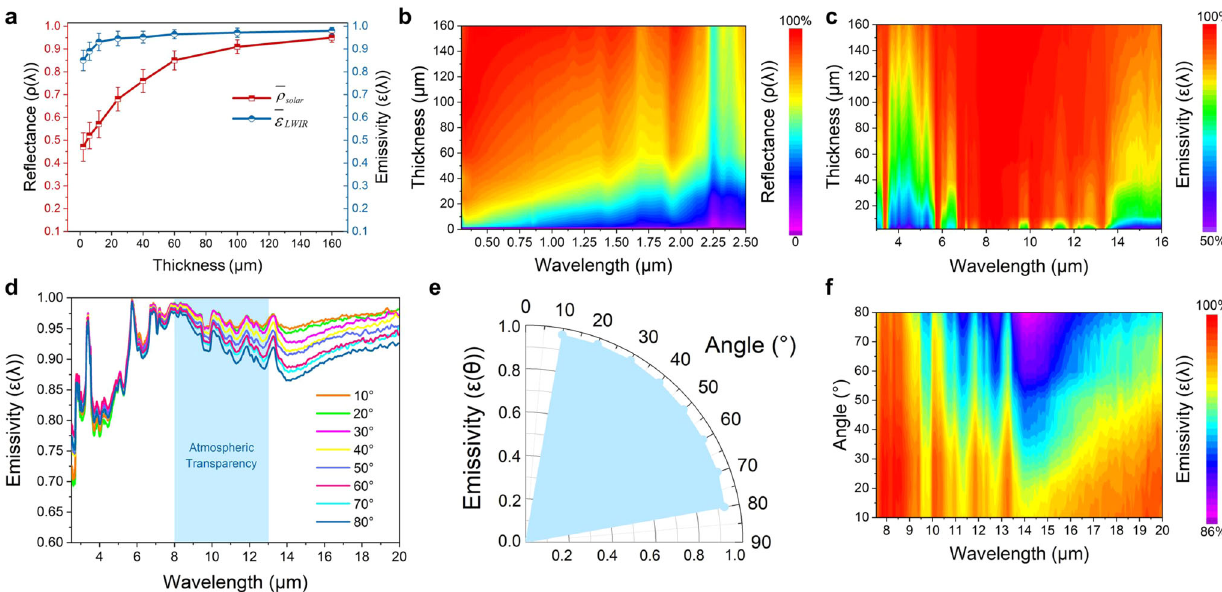
-- -- ρ ε fi lms with effective thickness and polarization angle. a Variation in (cid:1) ρ Fig. 3 Variation in and LWIR of the PMMA HPA solar fi lms with effective thickness. The error bars represent the standard deviation. b , c Measured re fl ectance and emissivity spectra of the PMMA function of the fi lm effective thickness. d Infrared emissivity spectra of a PMMA HPA fi lm at different polarization angles ( θ ) from 10° to 80°. e Polar distribution of the average emissivity across the atmospheric window of the PMMA HPA fi lm at different polarization angles ( θ ) from 10° to 80°. f Measured polarization-dependent infrared emissivity spectra of the PMMA HPA fi